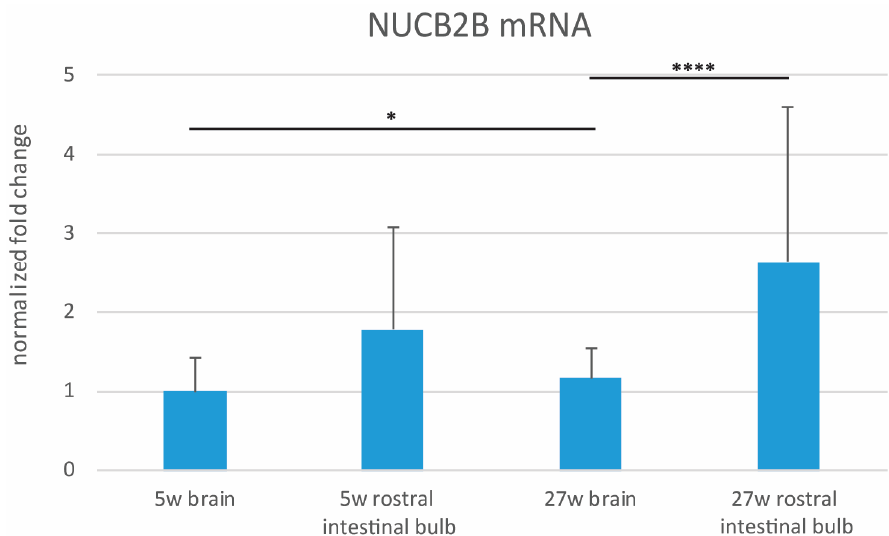
Figure 2. Expression levels of mRNA encoding NUCB2B in the brain and rostral intestinal bulb of young and old N. furzeri. The graphic was built on ∆∆ CT method and data were normalized to the young brain. T-test and p-value were calculated among young ( n = 12) and old ( n = 10) brains and young ( n = 12) and old ( n = 10) rostral intestinal bulbs. Furthermore, T-test and p -value were also calculated for young brains versus young intestinal bulbs and old brains versus old intestinal bulbs. ( p brain old versus young = 0.0169; p rostral intestine bulb old versus young = 0.0591; p young rostral intestinal bulb versus brain = 0.5899; p old rostral intestinal bulb versus brain = 0.0001). (*) indicates the level of significance.